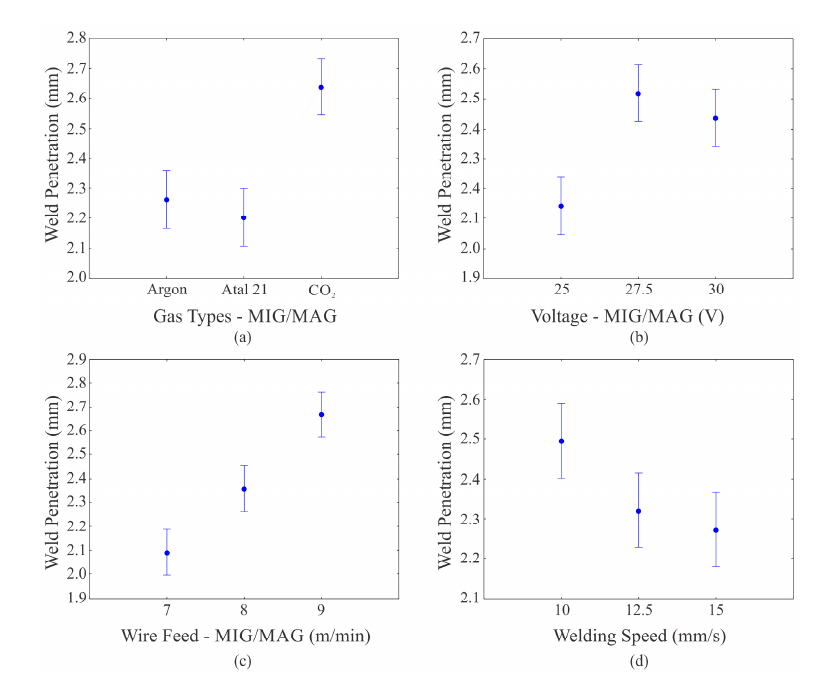
Figure 3. Effect of welding factors on penetration.